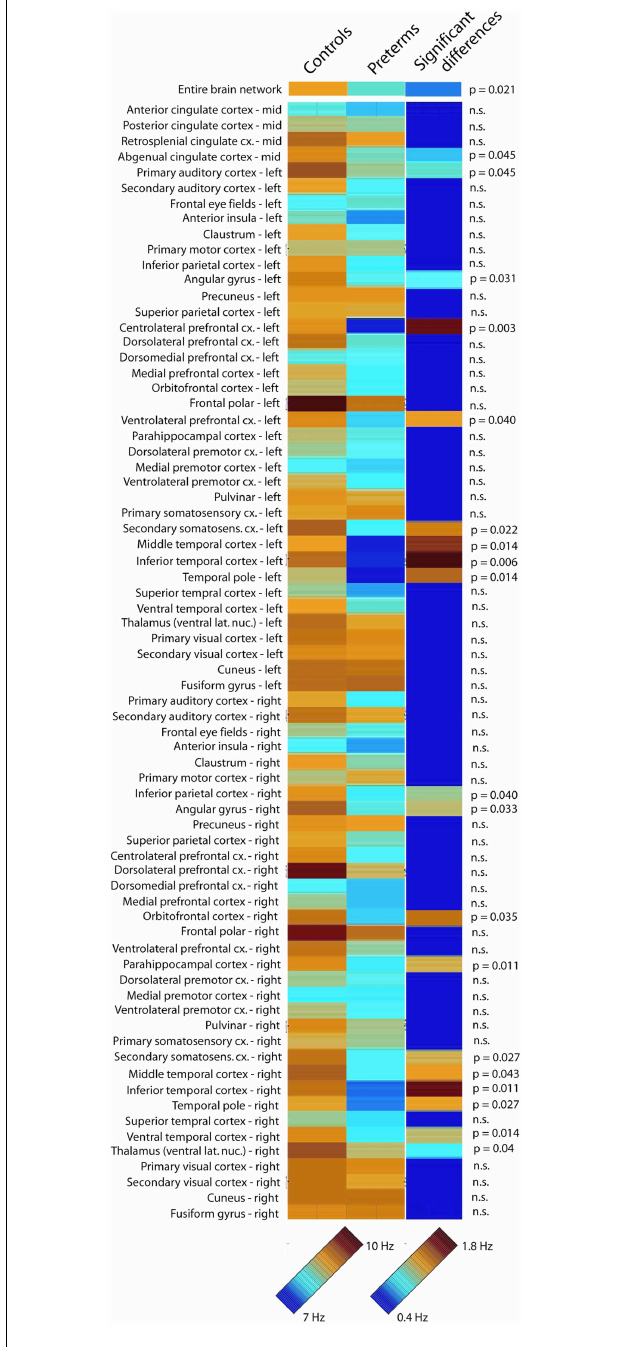
FIGURE 1 | Oscillatory slowing in very preterm children . Peak oscillatory frequency in each of the 72 analyzed brain regions for the full-term control and very preterm groups, as well as statistically significant regional slowing in children born very preterm.The 7- to 10-Hz scale bar corresponds to the peak oscillatory frequency for each analyzed region for the very preterm and typically developing groups.The 0.4- to 1.8-Hz scale bar indicates the difference in peak oscillatory frequency between the very preterm and typically developing groups for regions where statistically significant differences were observed (regions for which no significant group differences were observed are presented in dark